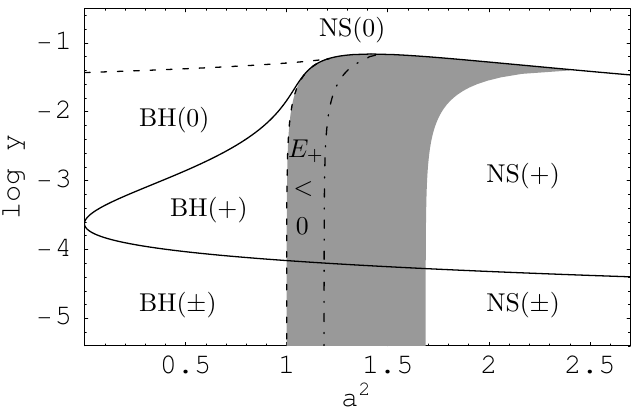
Figure 1. Classification of the Kerr–de Sitter spacetimes governed by the existence of stable circular orbits of test particles in the equatorial plane. Dashed curve separates regions of black holes (BH) and naked singularities (NS), full curves separate spacetimes admitting either both families ( circular orbits or the plus-family ( + ) only or even no (0) stable circular orbits. Shaded is the region of stable counterrotating plus-family